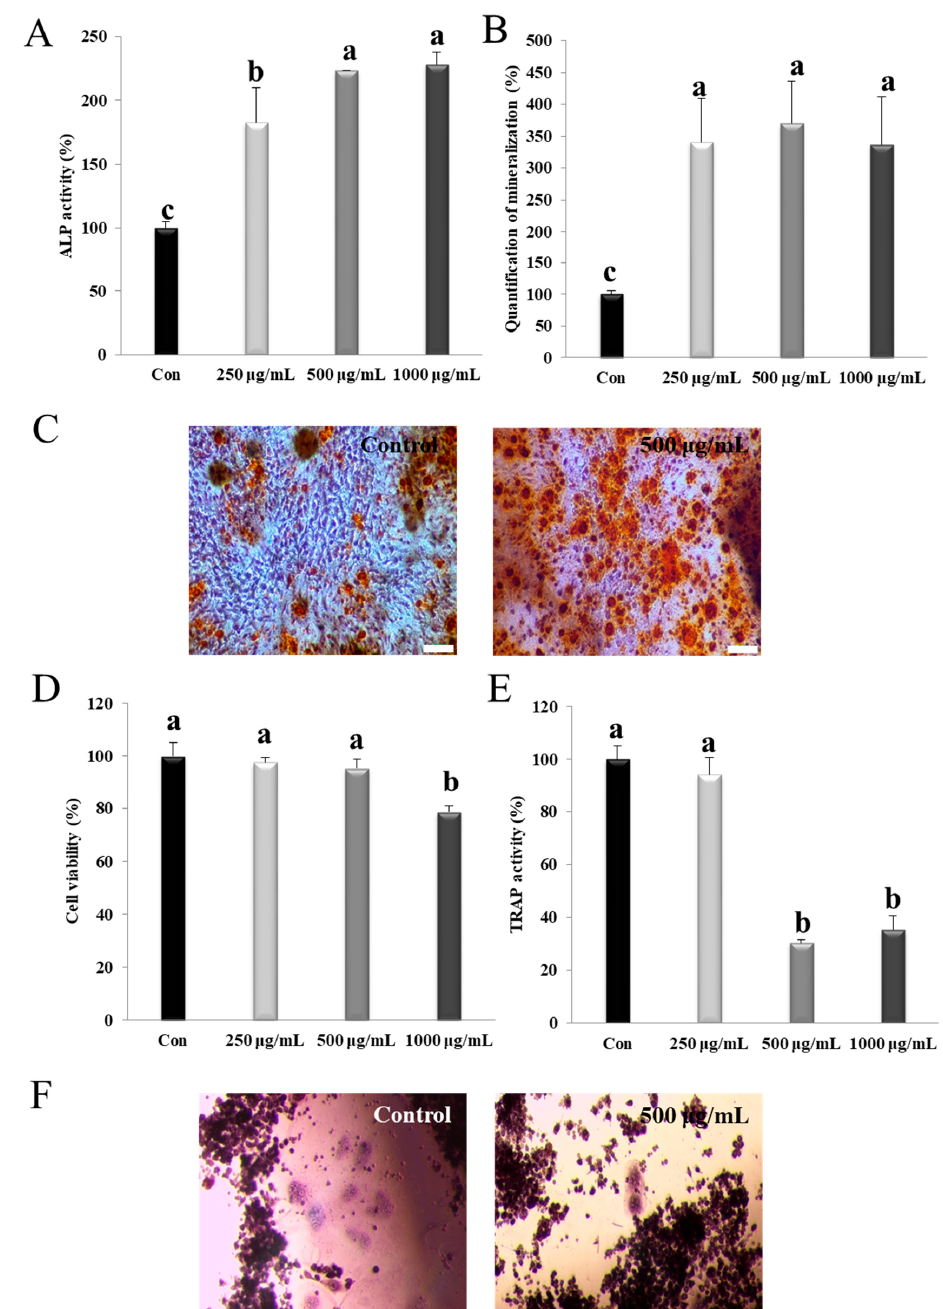
Figure 2. E ff ect of nano-montmorillonite (NM) on alkaline phosphatase (ALP) activity and mineralization during di ff erentiation in MG-63 cells. ( A ) Cells were treated with the indicated NM concentrations for 24 h before measuring the cell viability and for 96 h before measuring the ALP activity, as described in Materials and Methods. Scale bar: 20 µ m. ( B , C ) Cells were treated as indicated for 14 days before staining the mineralized matrix with alizarin red S and quantifying the mineralization as described in Materials and Methods. E ff ect of NM on RAW 264.7 cell viability ( D ), tartrate-resistant acid phosphatase (TRAP) activity ( E ), and TRAP staining ( F , control and NM 500 µ g / mL) during di ff erentiation. Scale bar: 20 µ m. Results are expressed as the mean ± SD. Values not sharing a common superscript ( a – c ) di ff ered significantly (Duncan’s multiple range test) ( p <